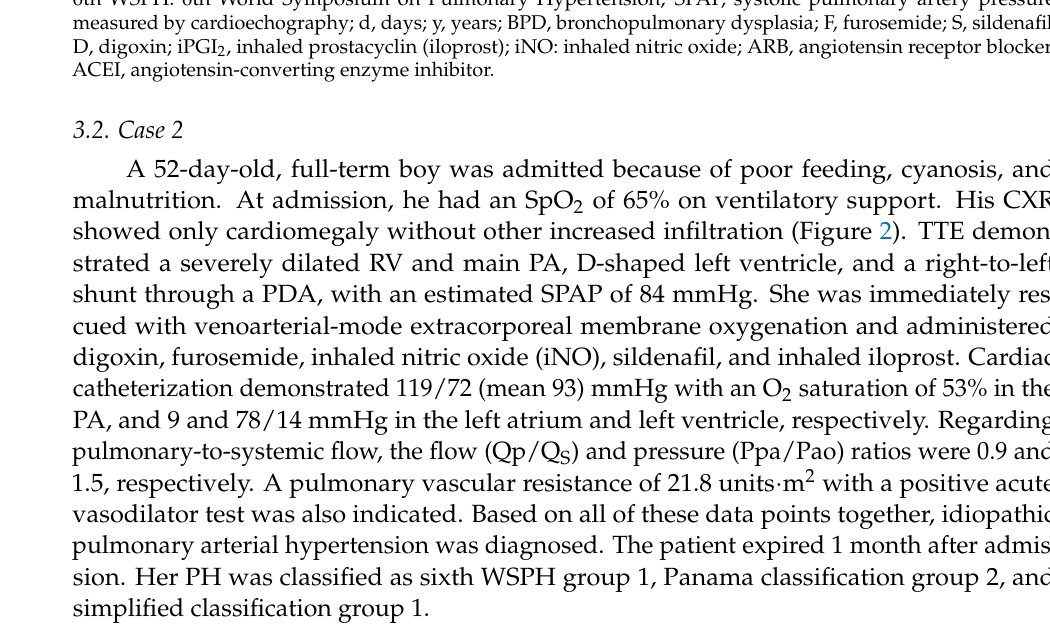
Table 1. Clinical and imaging characteristics of the patients with unique PH.